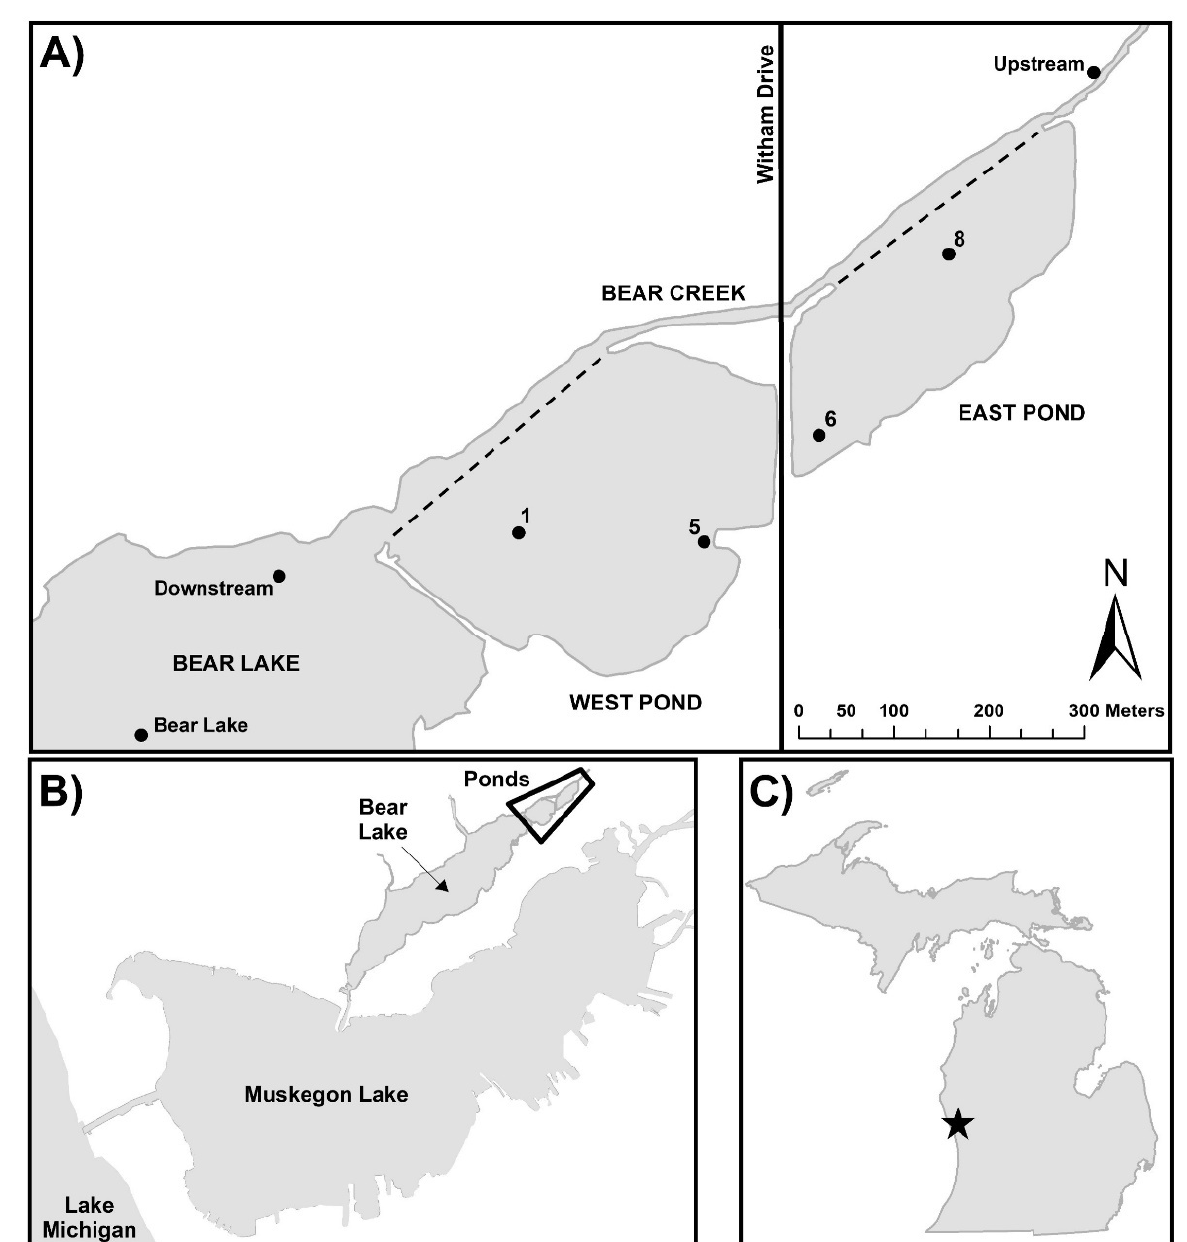
Figure 1. Map of study area: ( A ) magnified view of restoration site, including the reconnected ponds and Bear Creek following berm removal (former berm locations indicated by black dashed lines and water quality monitoring locations indicated by round symbols); see Figure 2 for view of berm; ( B ) location of restoration area (outlined in thick black lines) within the Muskegon Lake Area of Concern; and ( C ) location of Muskegon (star) in map of Michigan.